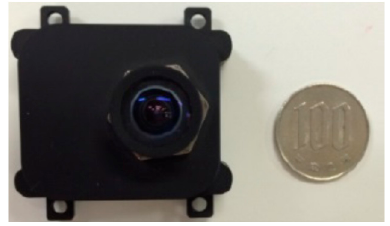
Figure 2. The RGB Camera used for MeznSat [16].